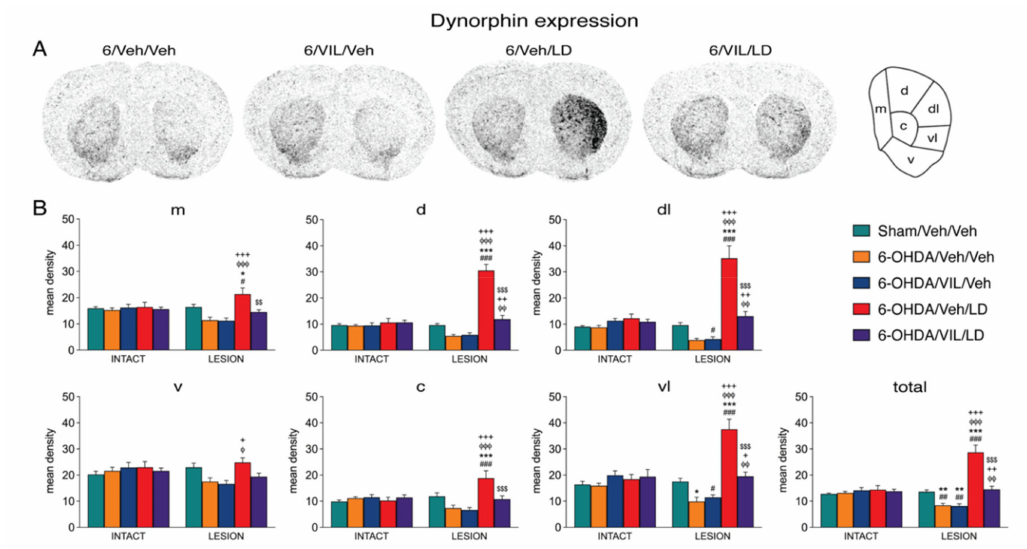
Figure 2. Vilazodone inhibited the L-DOPA-induced increase in dynorphin expression in the dopamine-depleted striatum. ( A ) Illustrations of film autoradiograms depict expression of dynorphin in sections from the mid-level striatum in rats with a 6-OHDA lesion (right hemisphere) followed by repeated vehicle (6-OHDA / Veh / Veh), vilazodone (10 mg / kg) + vehicle (6-OHDA / VIL / Veh), vehicle + L-DOPA (5 mg / kg) (6-OHDA / Veh / LD), or vilazodone + L-DOPA treatment (6-OHDA / VIL / LD). Animals were killed 60 min after the L-DOPA injection. The maximal hybridization signal is in black. ( B ) Mean density values (mean ± SEM) for dynorphin expression in the mid-level striatum on the intact side or the side of the lesion in the sham lesion controls (Sham / Veh / Veh) and the 6-OHDA / Veh / Veh, 6-OHDA / VIL / Veh, 6-OHDA / Veh / LD, and 6-OHDA / VIL / LD groups. Gene expression was measured in six sectors and the total middle striatum (upper right). m, medial; d, dorsal; dl, dorsolateral; vl, ventrolateral; c, central; v, ventral. # p < 0.05, ## p < 0.01, ### p < 0.001 vs. same group on the intact side; * p < 0.05, ** p < 0.01, *** p < 0.001 vs. Sham / Veh / Veh; ϕ p < 0.05, ϕϕ p < 0.01, ϕϕϕ p < 0.001 vs. 6-OHDA / Veh / Veh; + p < 0.05, ++ p < 0.01, +++ p < 0.001 vs. 6-OHDA / VIL / Veh; $$ p < 0.01, $$$ p < 0.001 vs. 6-OHDA / Veh /